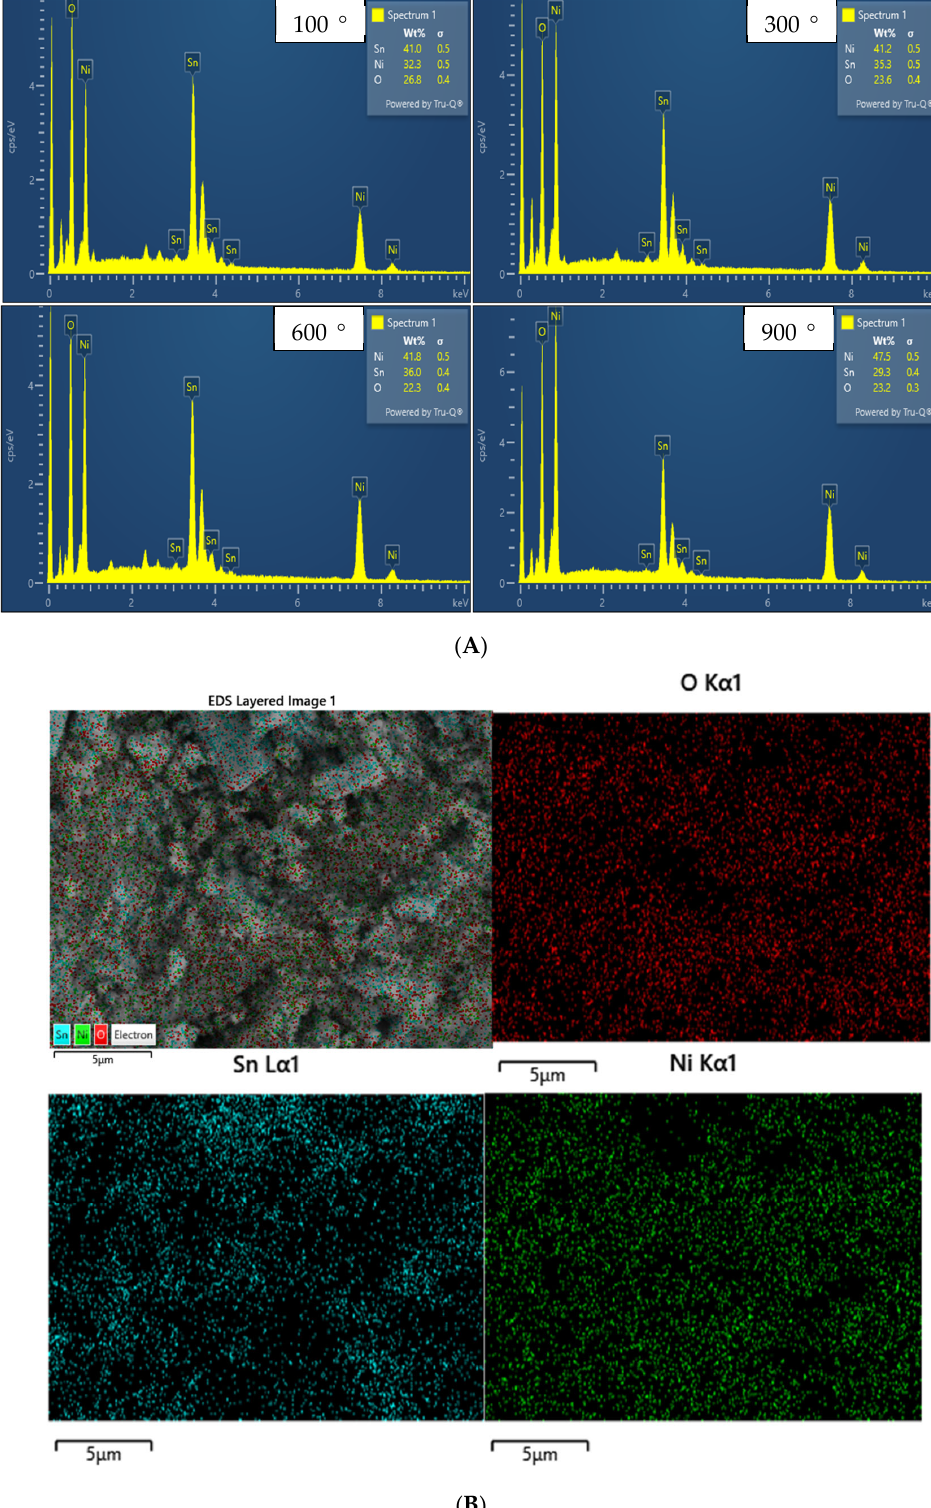
Figure 6. ( A ) EDX spectra of NiO ‐ SnO 2 NCs calcined at different temperatures. ( B ) EDX mapping images of NiO ‐ SnO 2 NCs calcined at 900 ° C; red = O; blue = Sn; green = Ni.